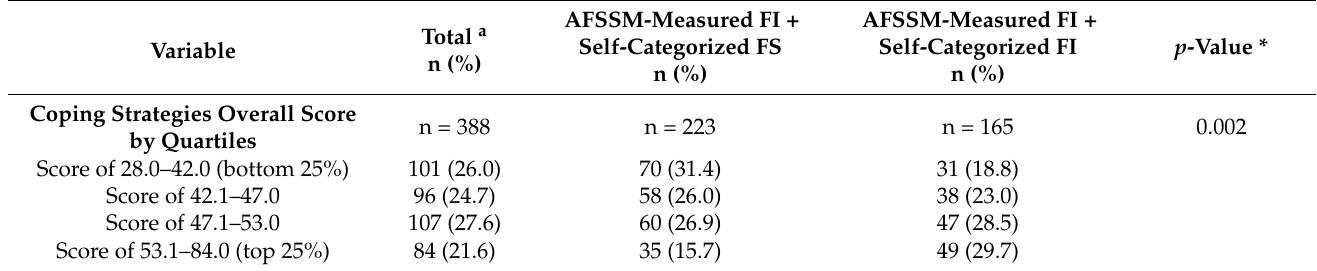
Table 4. Differences in Overall Coping Strategies Scale Score by Self-Categorized Food Security Status among College Students AFSSM-Measured as Food Insecure (n =